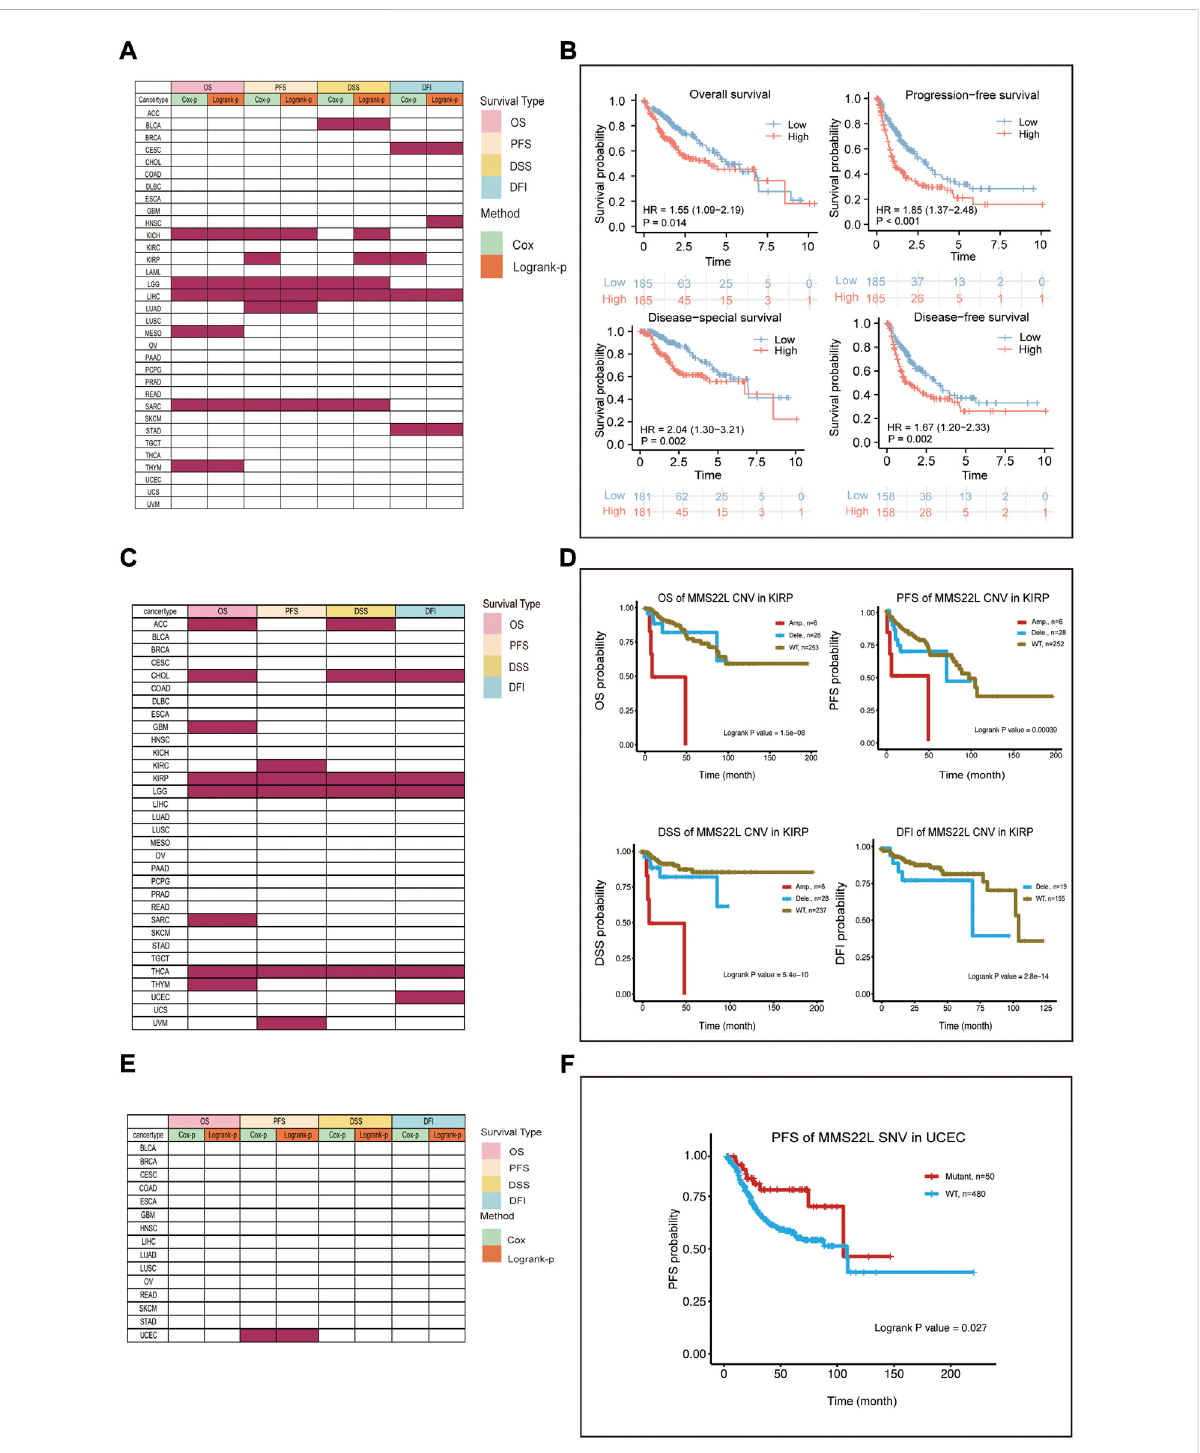
FIGURE 2 Survival landscape of methyl methanesulfonate-sensitivity protein 22-like (MMS22L) in pan-cancer. (A) Summary of the correlation between mRNA expression of MMS22L with OS, DSS, DFI, and PFI based on the univariate Cox regression and log-rank tests in pan-cancer. (B) High mRNA expression of MMS22L was associated with worse outcomes in patients with HCC. (C) Summary of the correlation between the copy number variation status of MMS22L using OS, DSS, DFI, and PFI based on the log-rank tests. (D) Ampli fi cation of MMS22L is associated with a worse prognosis in kidney renal papillary cell carcinoma. (E) Summary of the correlation between the single-nucleotide variant status of MMS22L and OS, DSS,PFI,andDFIbasedontheunivariateCoxregressionandlog-ranktests. (F) PatientswithmutatedMMS22Lhadabetterprognosisofprogression- free survival in uterine corpus endometrial